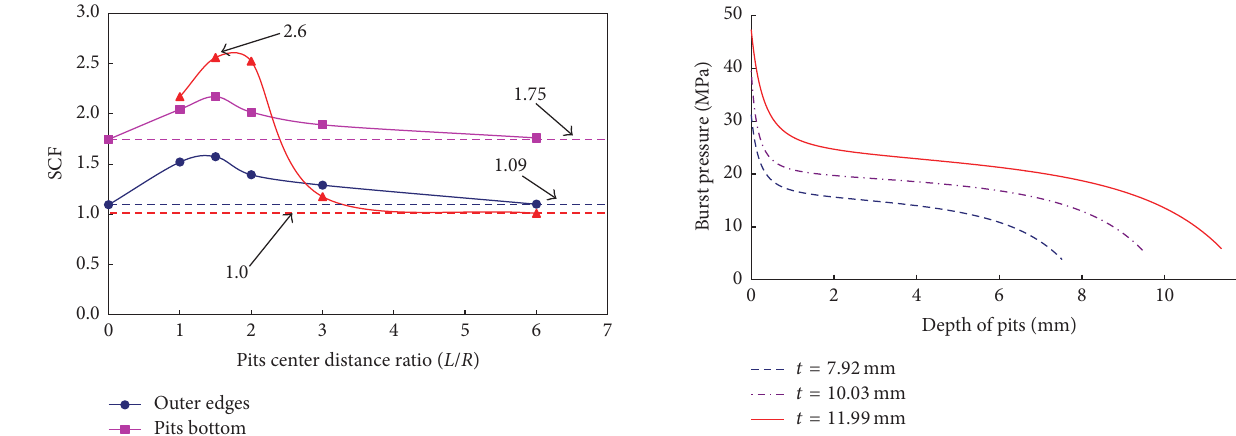
Figure 11: The relationship between pit depth and burst pressure. factor of 1.3 was recommended in the double pits SCF prediction model. (3) The stress concentration factor caused by corrosion pits can be applied to estimate internal pressure strength reduction of casing. When the depth of pit reaches half of the wall thickness, the SCF factor will increase faster. Stress concentration can degrade the casing strength